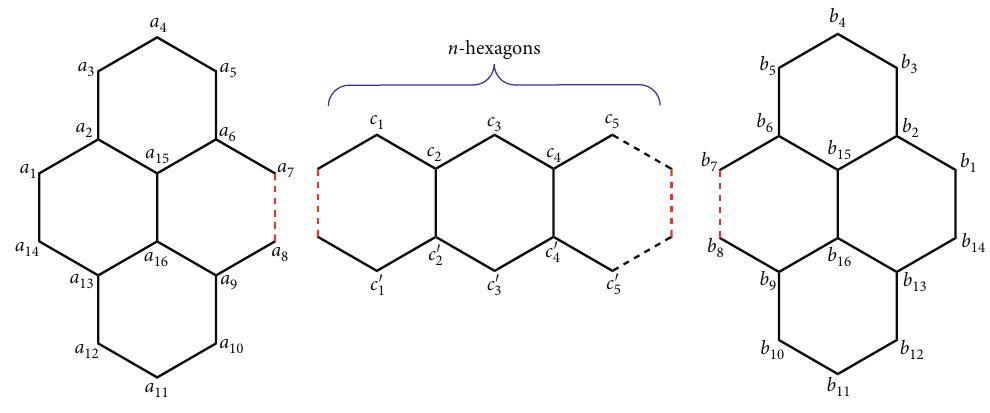
Figure 1: Benzenoid hammer with n �